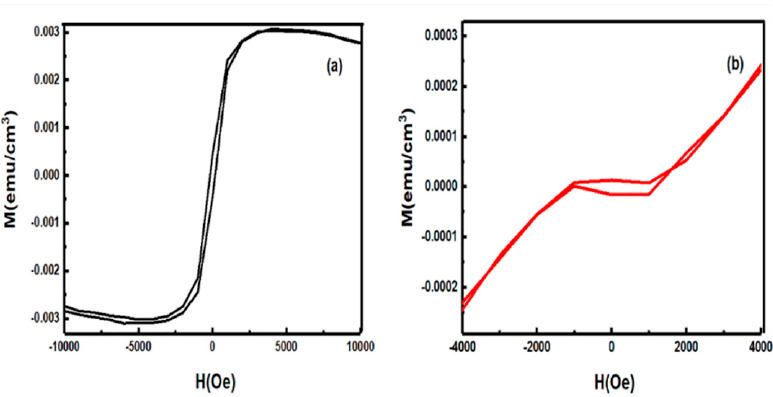
Figure 15. M(H) data for ( a ) AZO1 and ( b ) AZO2. Reproduced with permission from Ref. [61]; published by Springer Nature, 2019.